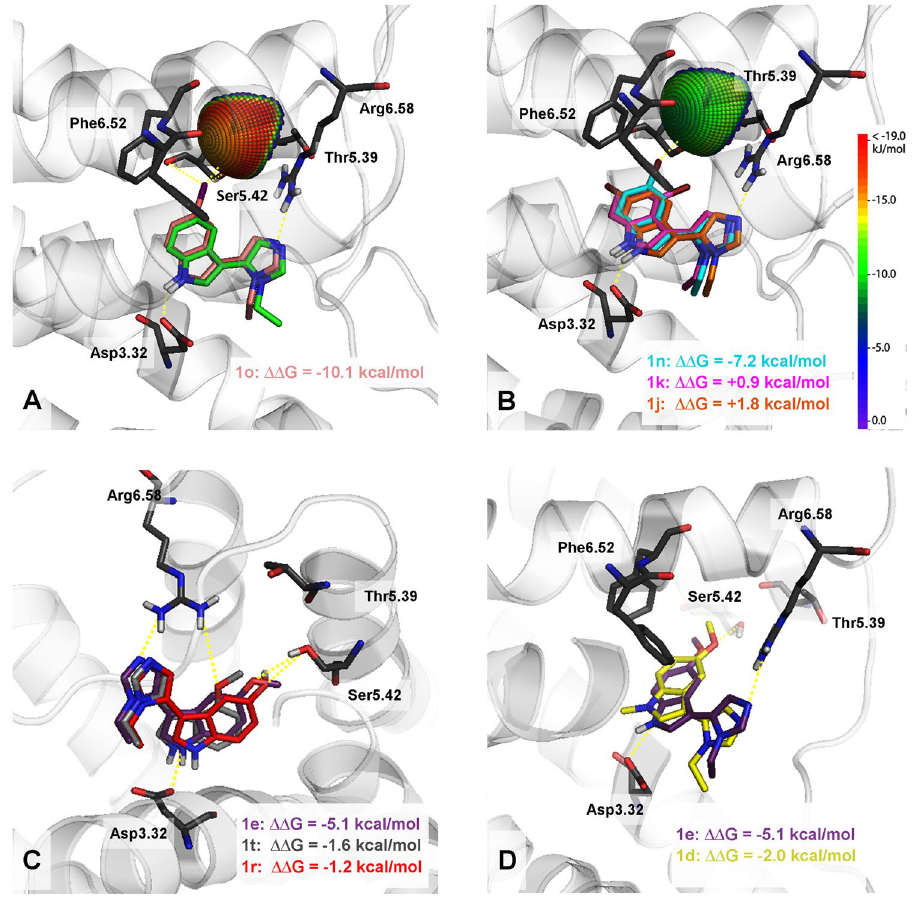
Figure 6. Representative complexes (top scores based on Δ G) of selected ligands with the 5-HT 7 receptor model. Amino acids that were selected as crucial for the binding of the presented compounds are shown as sticks. The ∆∆ G [kcal/mol] value shows the difference between the ∆ G of complexes of a particular compound ( 1d , 1 f , 1j , 1k , 1n , 1r , 1t ) and an unsubstituted analogue 1w (green in Fig. A). In all cases except 1d (R2 = Me, yellow in Fig. D), the ∆∆ G values correspond to the binding affinity. ( A ) – halogen bond formation between the iodine atom of 1o and the receptor. ( B ) – 1j (R5 = Br) and 1k (R3 = Br) which do not pass geometrical parameters needed for halogen bond formation and 1n halogen bonded to the receptor. ( C ) – differences in binding modes of compounds 1e (R4 = OMe), 1r (R4 = OH) and 1t (R3 = OMe), the lack of interaction of 1t with Ser5.42 is compensated by the formation of additional hydrogen bond with Arg6.58. ( D ) – the inability of 1d (R2 = Me) to interact with Asp3.32.